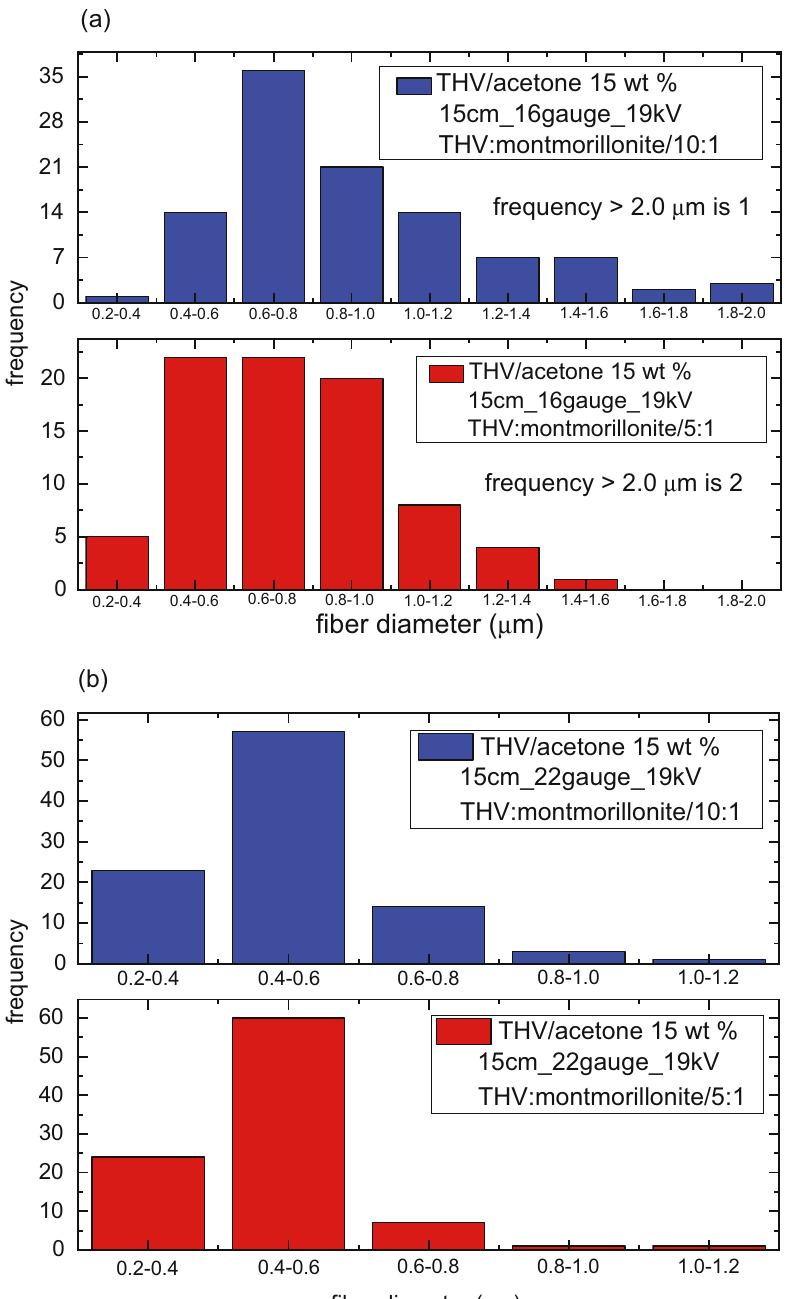
Figure 7: Histogram of fi ber diameter distribution when the fi bers were prepared from 15 wt% montmorillonite added THV/acetone solution: ( a ) 16 - gauge and ( b ) 22 -